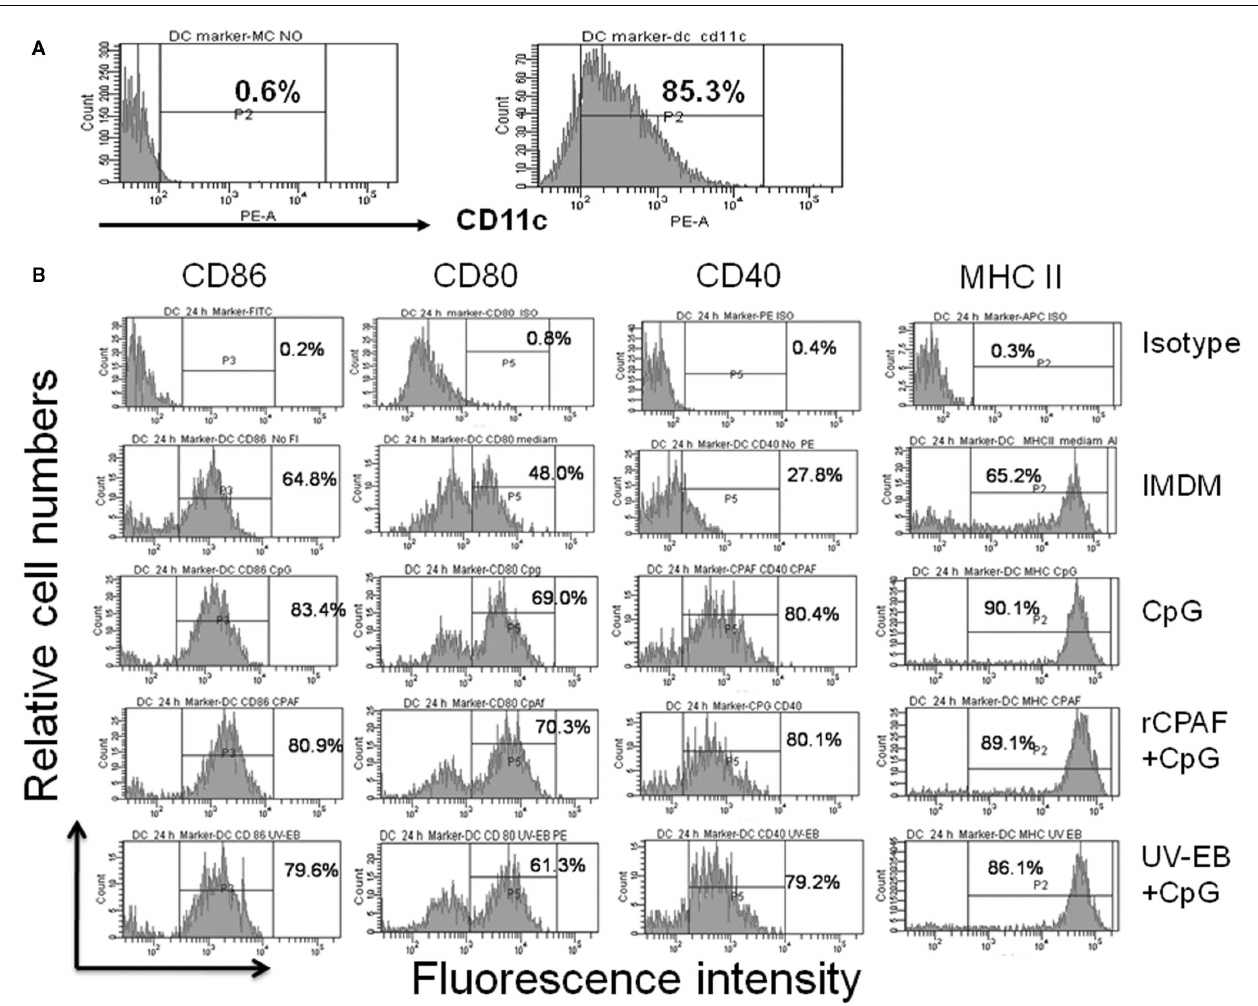
and Methods.” Harvested DCs were surface stained for antibodies against CD86, CD80, CD40, and MHC II.The percentages of positive cells are indicated. One experiment from two independent experiments with similar results is